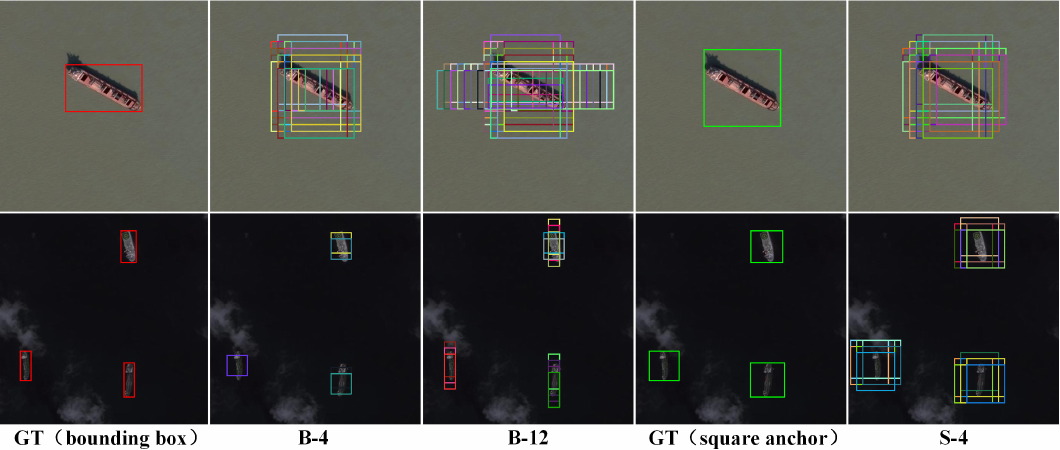
Figure 3. Some positive examples of different types of anchors. B and S represent original anchor and square anchor, respectively, followed by the number of